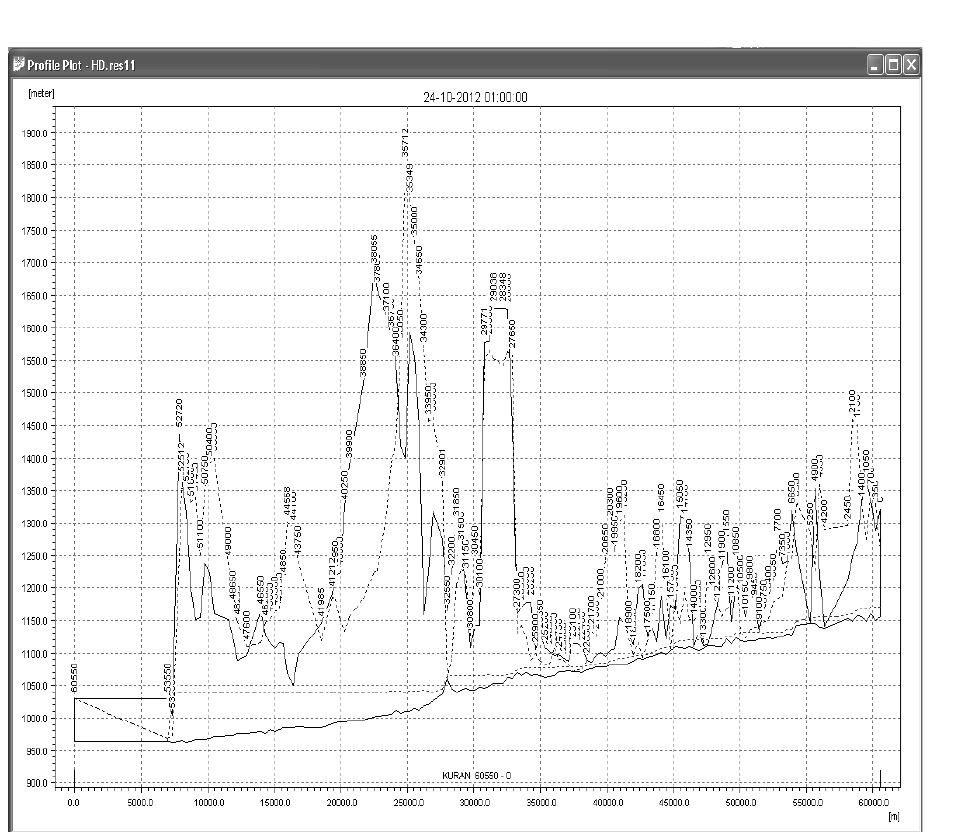
Fig. 3: Output of the MIKE-11 Model for flood zoning of Gavi